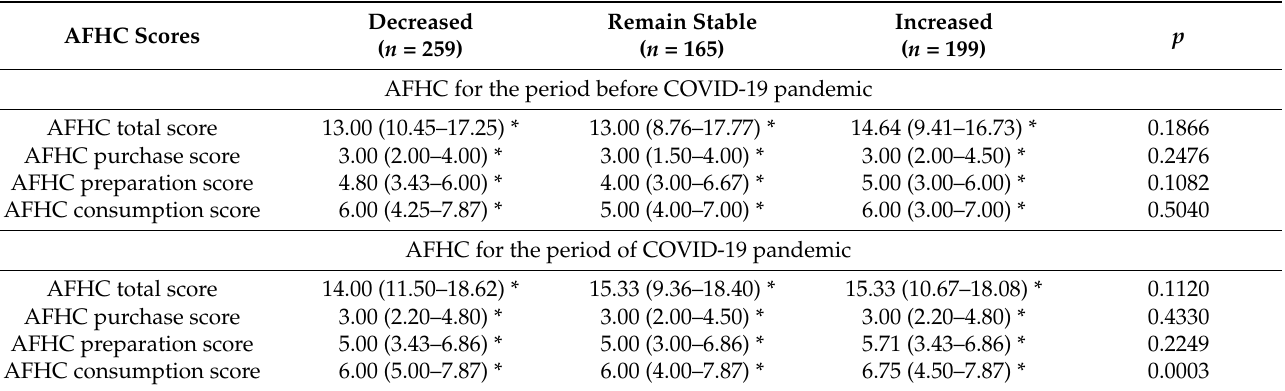
Table 5. The Adolescents’ Food Habits Checklist (AFHC) scores for the period before the COVID-19 pandemic and for the period of COVID-19 pandemic, stratified by physical activity changes during the COVID-19 pandemic, for the population of male adolescents from the Diet and Activity of Youth during COVID-19 (DAY-19) Study ( n =